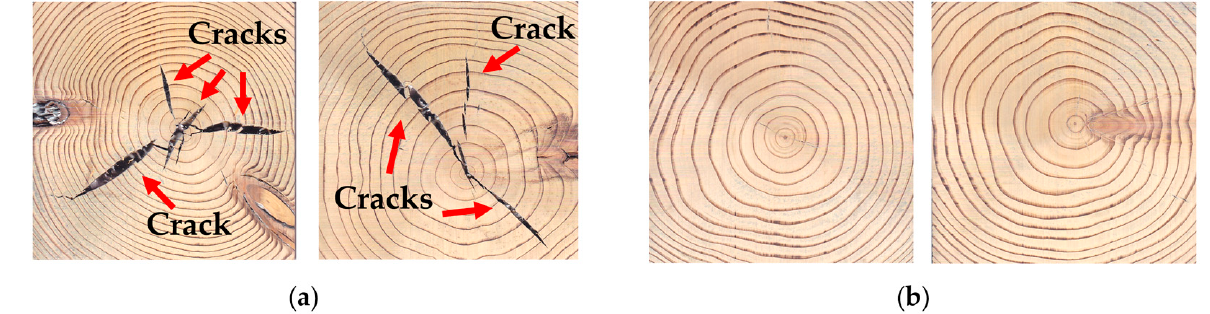
Figure 1. Images of cross-sections of cedar square timbers. ( a ) Example of internal cracks; ( b ) No cracks without risk to physical strength.